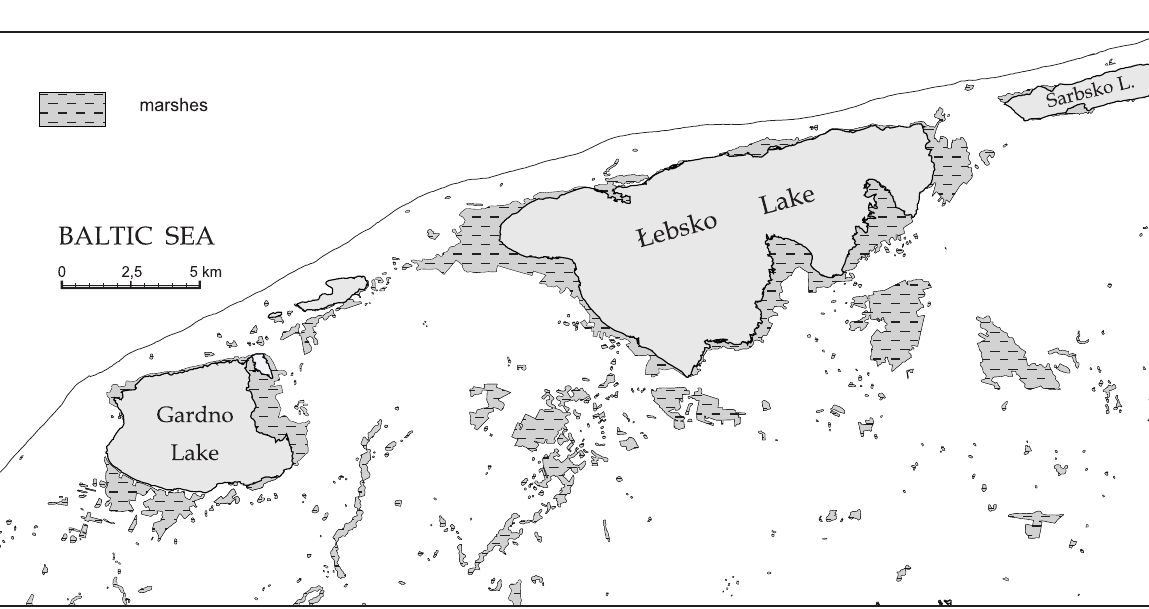
Fig. 7. Extent of wetlands in Gardno-Łeba Lowland in the second half of 20th